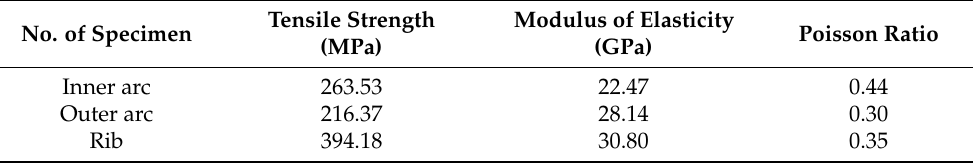
Table 2. Test results of PFRP tensile test .